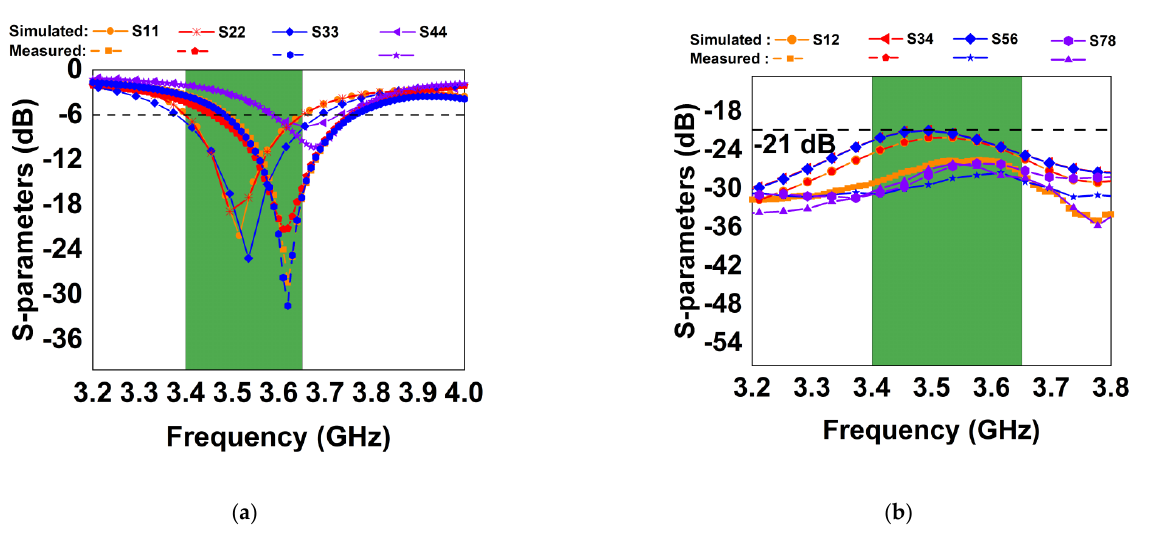
Figure 6. Simulated and measured scattering parameters ( a ) reflection parameters and ( b ) transmis- sion parameters value.